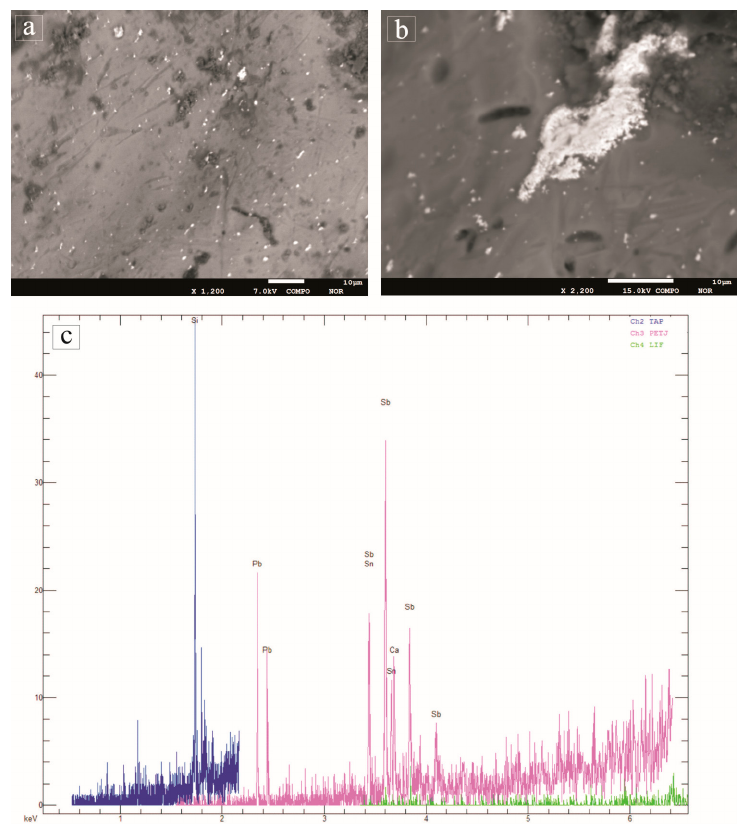
Figure 8. ( a ) Backscattered electron image showing micrometric crystals of Pb-Sn-antimonate embedded in the glass matrix of the yellow QsG1 tessera; ( b ) detail of a Pb-Sn-antimonate micro-crystal; ( c ) Spectrum of Pb-Sn-antimonate by EPMA-WDS qualitative analysis. Minerals 2020 , 10 , 658 The red tessera (QsR1) contains a considerable quantity of lead oxide (9.22 wt.%) and a copper